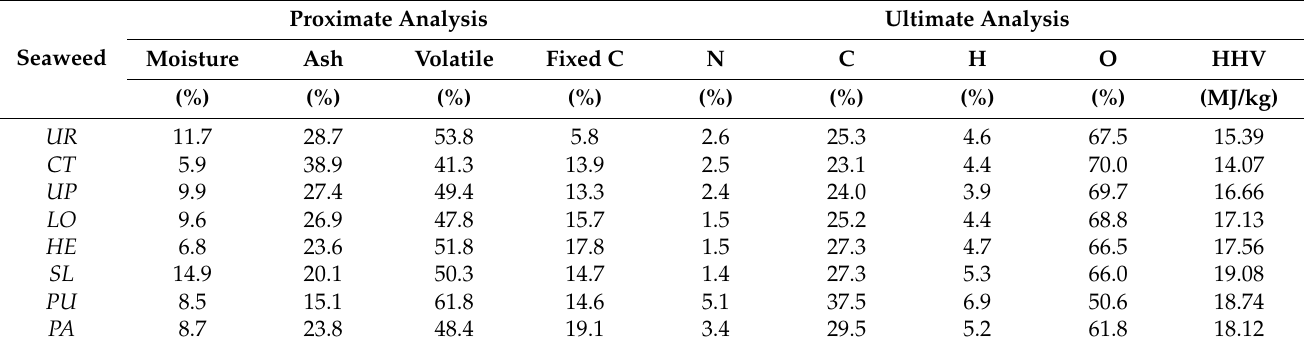
Table 4. Proximate and ultimate analysis of the studied